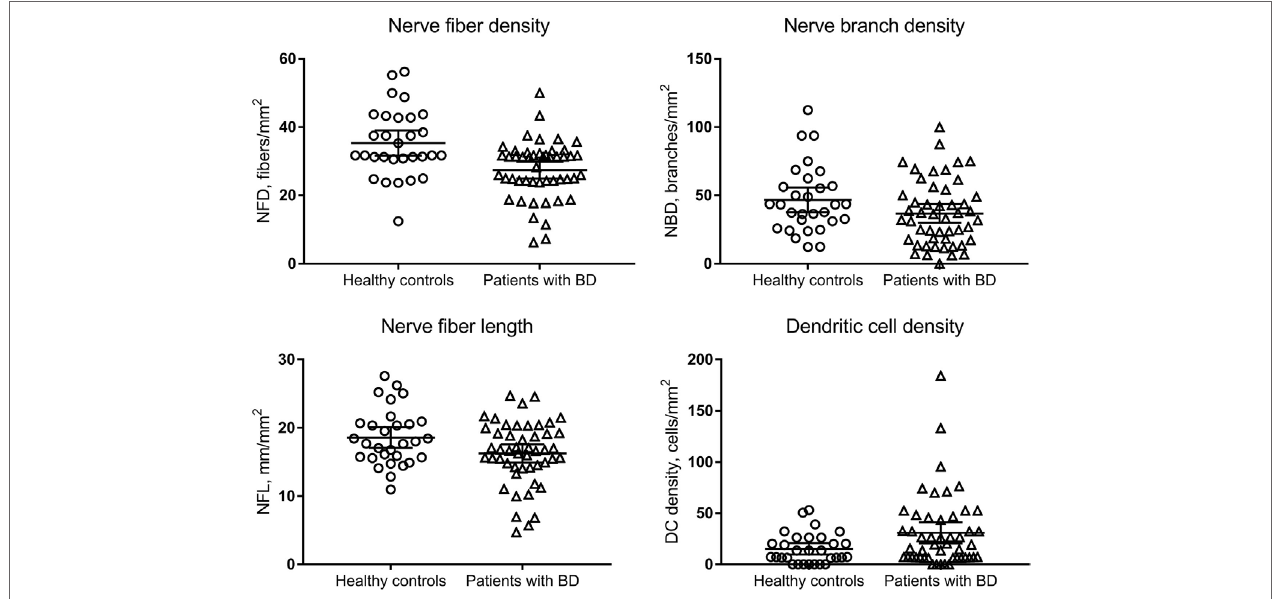
FigUre 3 | Comparison of corneal subepithelial nerve parameters and dendritic cell (DC) density between healthy control subjects and patients with Behçet’s disease (BD). Patients with BD had a lower nerve fiber density (NFD, P = 0.001) and nerve fiber length (NFL, P = 0.031), and higher DC density ( P = 0.038) with no difference in nerve branch density (NBD, P = 0.067) compared to